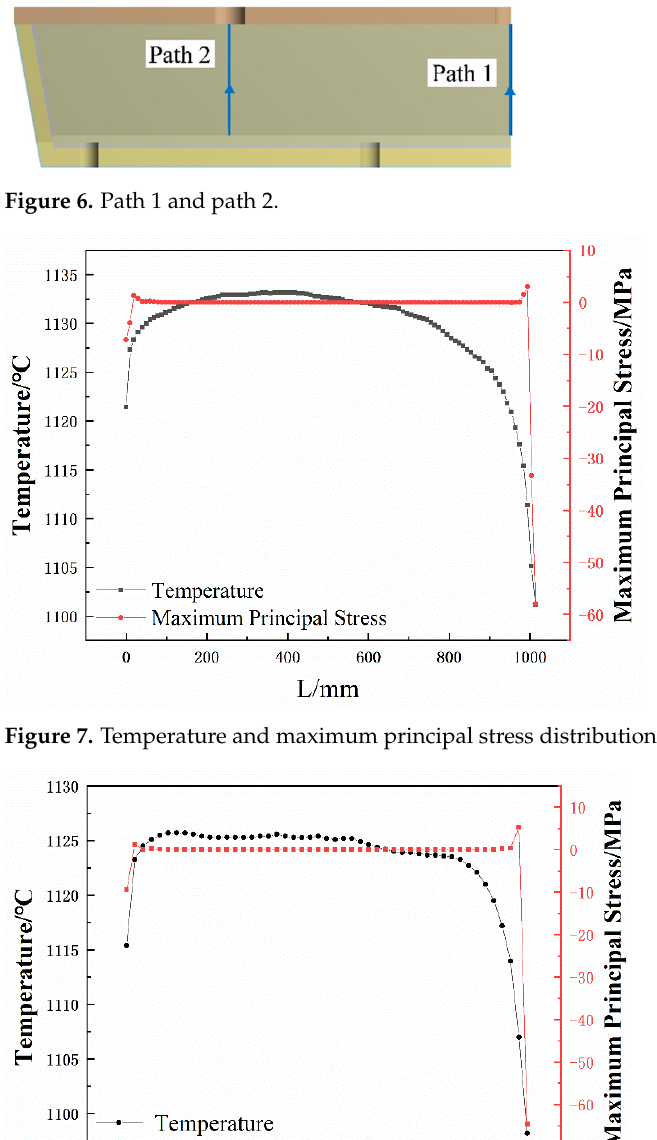
Figure 9. Strength characteristics of the dry vibrating material of the working layer [24]. 5. Conclusions (1) The temperature field distribution on the hot surface of the working layer gradually develops toward uniformity with the increase in preheating temperature, while the